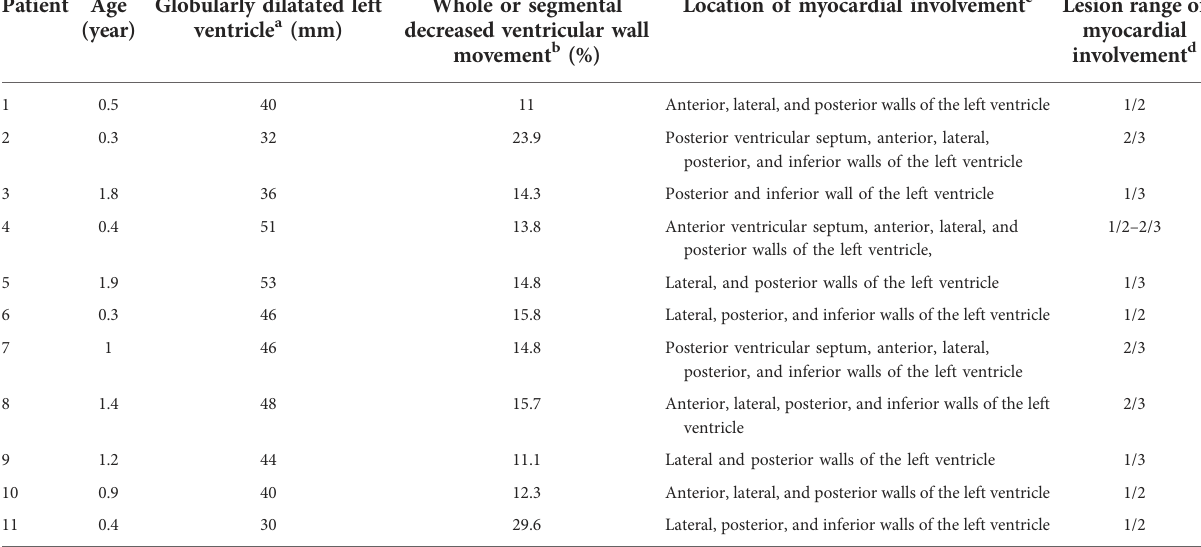
TABLE 2 Morphological fi ndings of CMR in 11 patients with EFE. Whole or segmental Patient Age Globularly dilatated left decreased ventricular wall (year) ventricle a (mm)